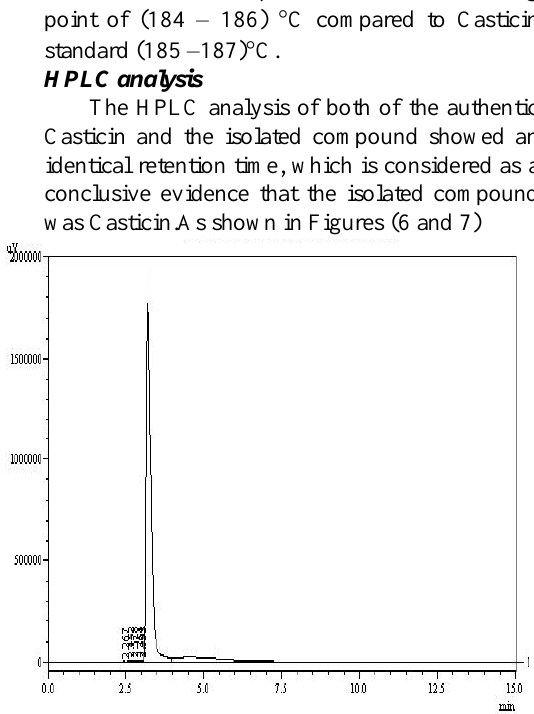
Figure 6: HPLC analysis of Casticin standard